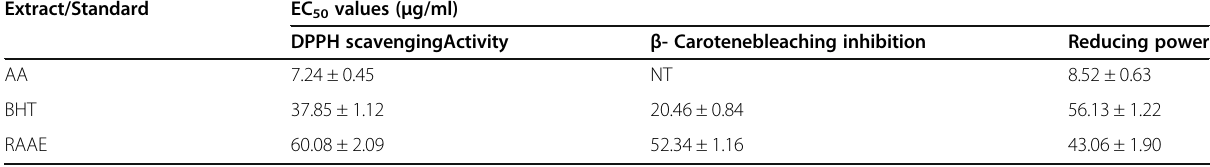
Table 2 DPPH free radical scavenging activity, reducing power, and β -carotene bleaching inhibition of RAAE Extract/Standard